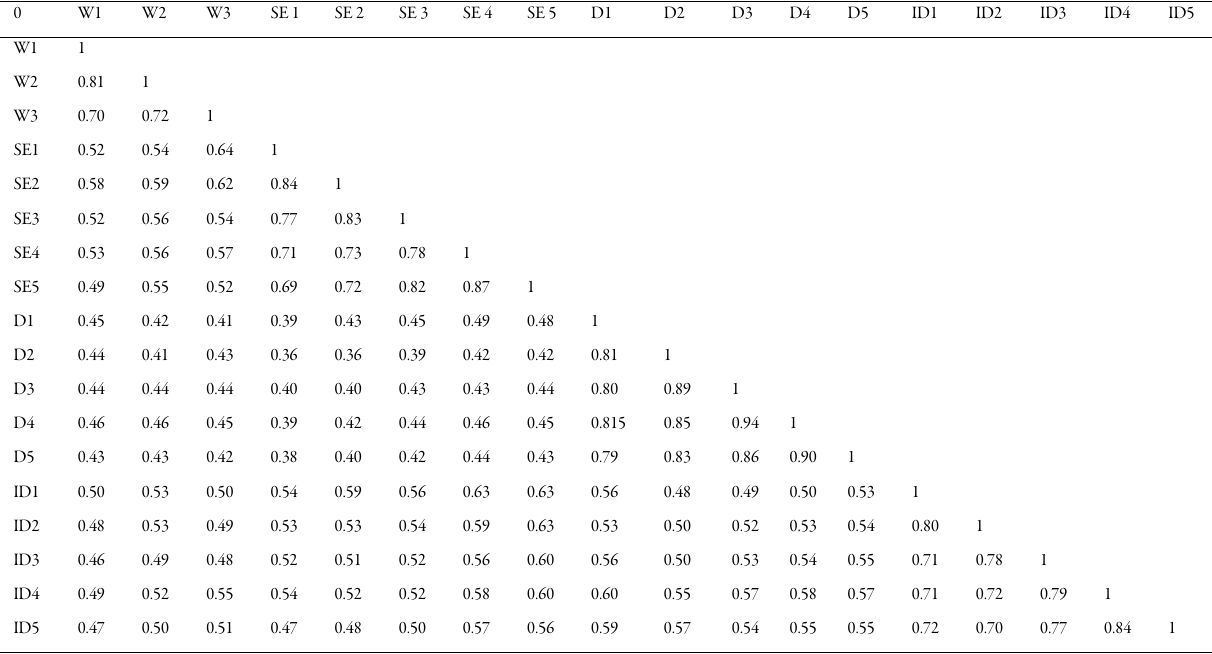
Table 5. Jaccard’s similarity coefficient based RAPD data of the in vitro propagated shoots through SE=Somatic embryogenesis, D=Direct organogenesis, ID=Indirect organogenesis and W=wild